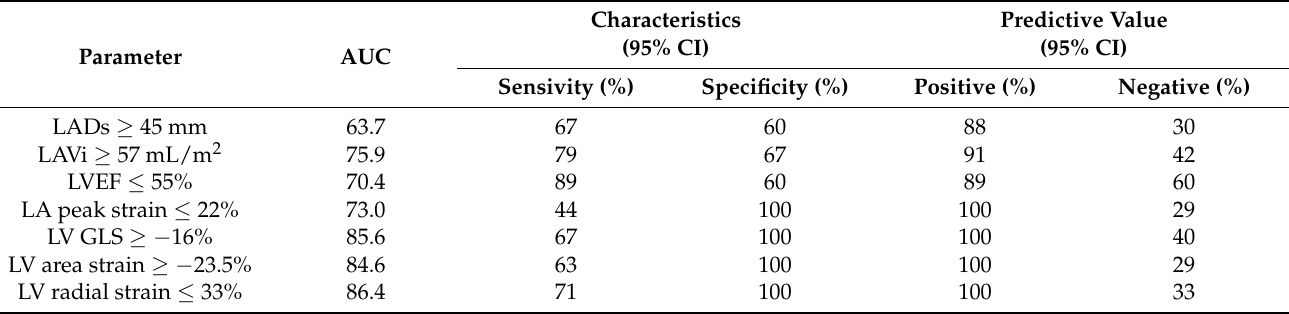
Table 3. Cut-off values and prognostic accuracy of the analyzed 2D and 3D STE parameters (calculated in the ROC analysis) as predictors of AF presence.